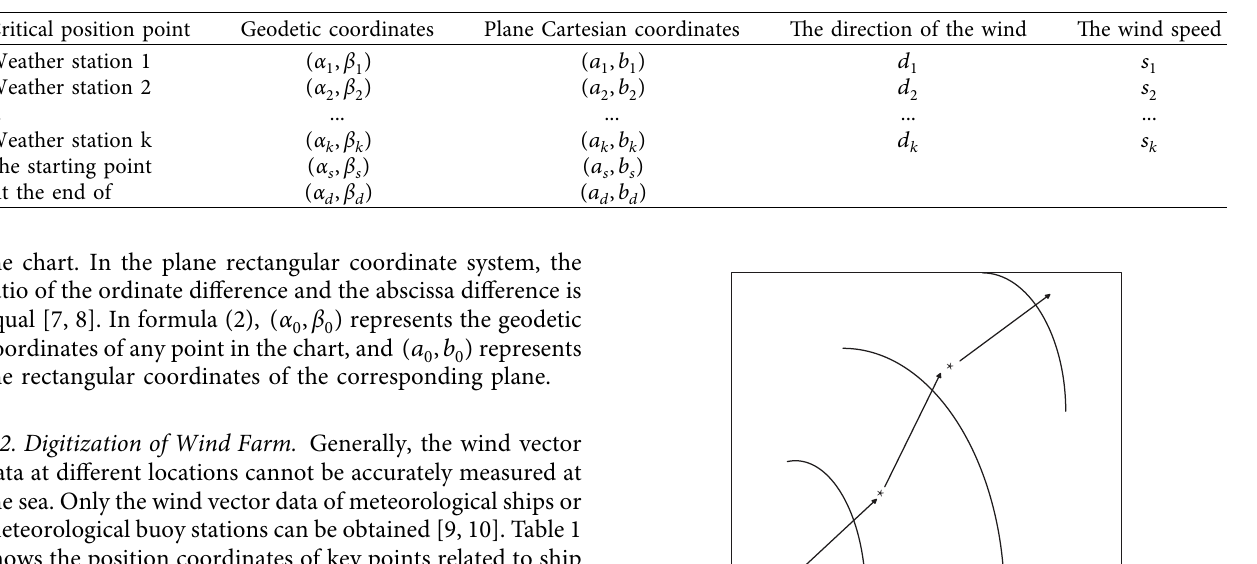
Table 1: Initial data of key position points related to route planning.